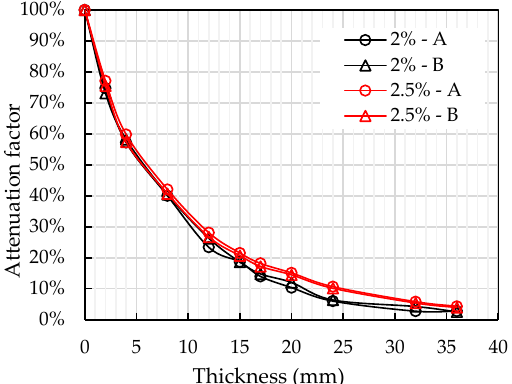
Figure 5. Attenuation factors of 2% and 2.5% vol. specimens at different thicknesses.